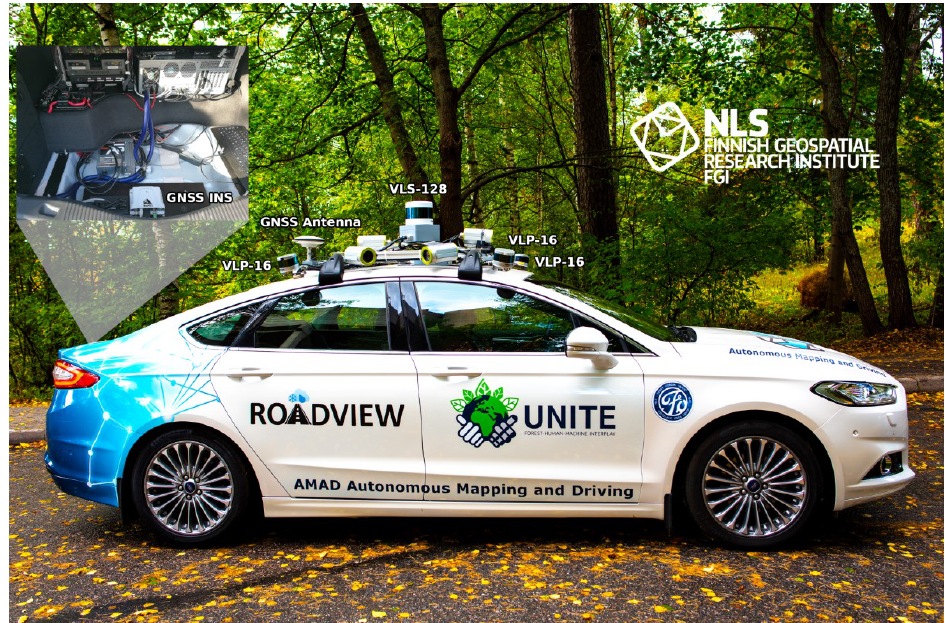
Figure 2. Photograph of the autonomous mapping and driving research platform, ARVO, which was used to record the autonomous perception data in this study. The inset shows the trunk of the ARVO car.